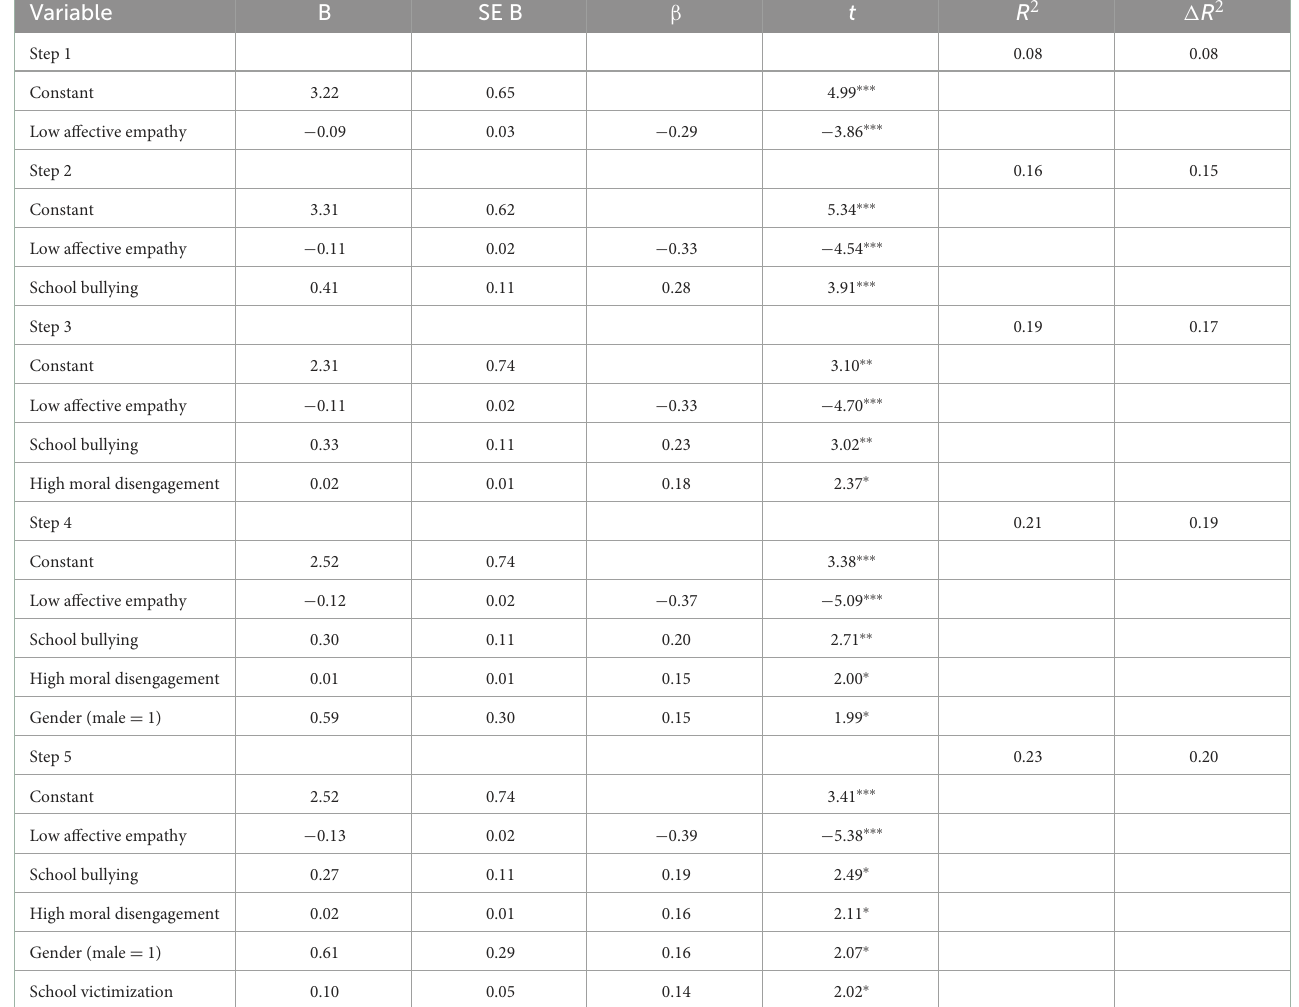
TABLE 6 Multiple linear regression analysis (stepwise) results regarding onset of cybervictimization.